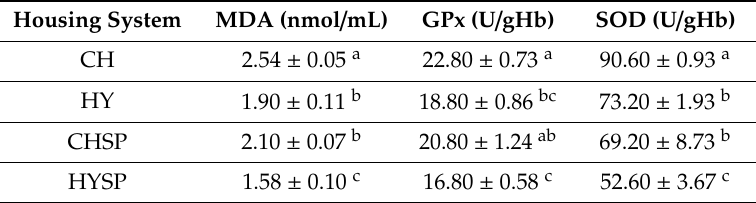
Table 5. E ff ect of di ff erent housing systems on oxidative stress of Pekin ducks.